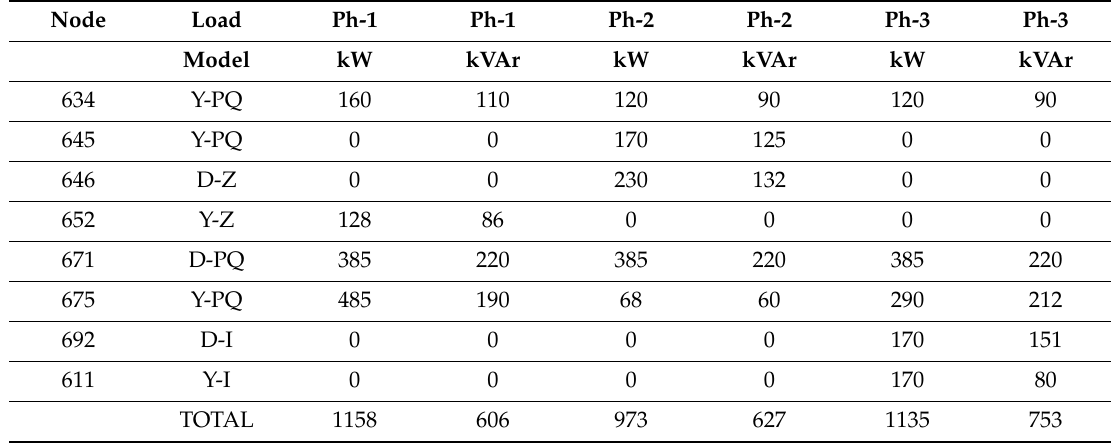
Table A1. Spot Load Data.